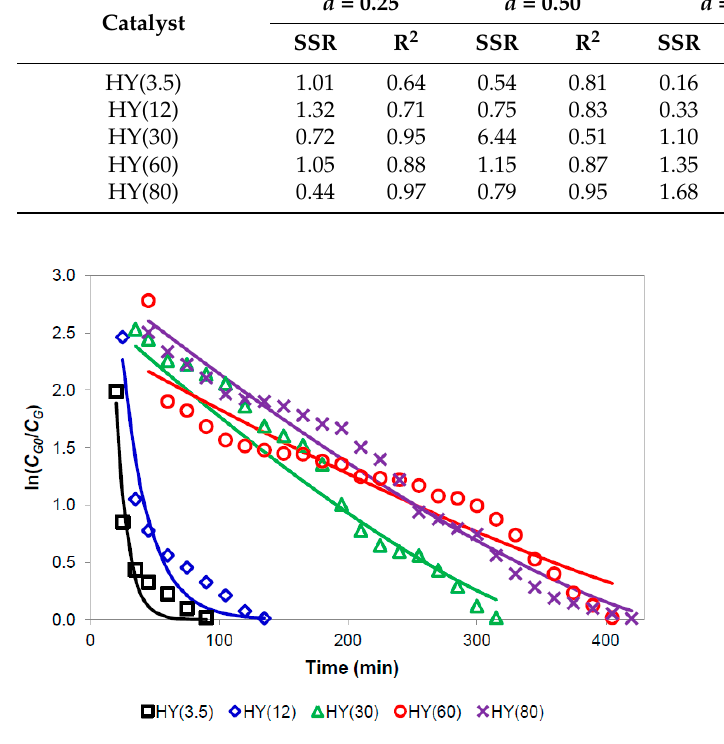
Figure A3. Catalytic activity as a function of time on stream of the HY zeolites.